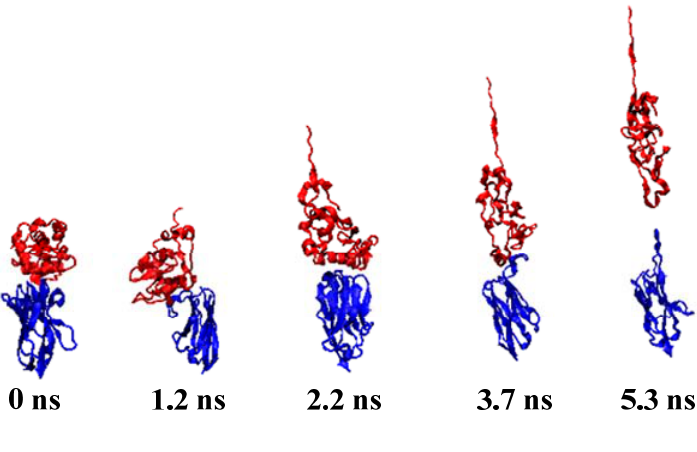
Figure 5. Snapshots from pulling rates: 0.00005 Å/time-step. Lysozye (red) and VHH HL6 antibody